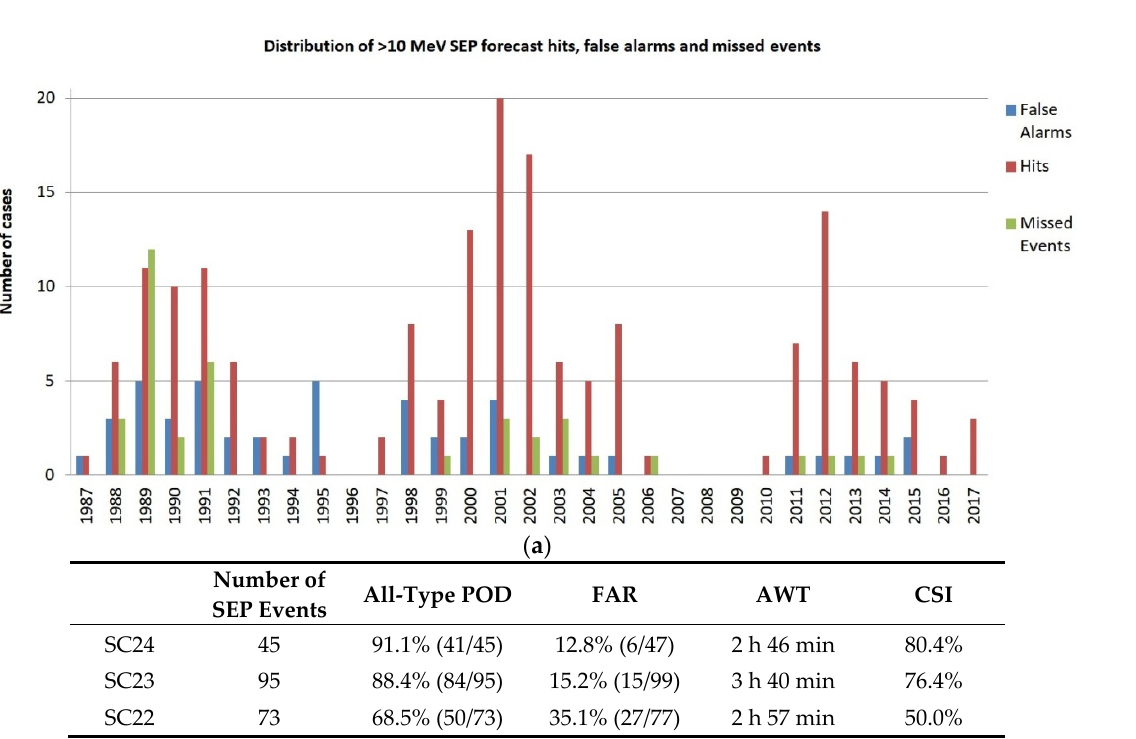
Figure 2. This figure presents the forecasting performance of UMASEP-10 version 2.2 (the most re- cent version of this tool) for the >10 MeV events and start times in Bain et al. [2] for the solar cycles 23 (1997–2007) and 24 (2008–2 019), and in the SWPC SEP event list in https://umbra.nas- com.nasa.gov/SEP (accessed on 1 December 2021) for SC22 (1986–1996) . ( a ) Distribution of >10 MeV SEP forecast hits, false alarms and missed events using 33 years of 5 min continuous soft X-ray and proton data for the period 1987–2019. ( b ) Summary of these results in terms of all-type POD, FAR, AWT and